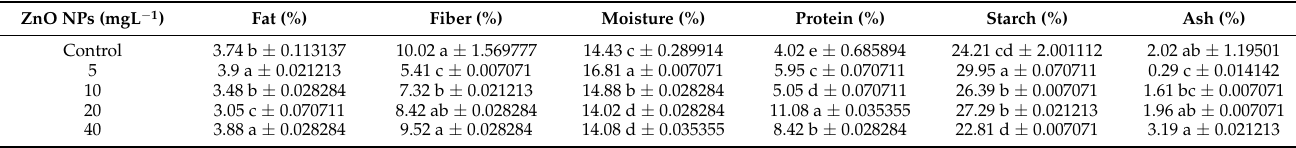
Table 5. Zinc oxide nanoparticles (ZnO NPs) impact fat, fiber, moisture, protein, starch, and ash percentage (%) in the C. longa rhizome. Mean values followed by the same letter within a column are not significantly different at p = 0.05, as measured by Duncan’s test.